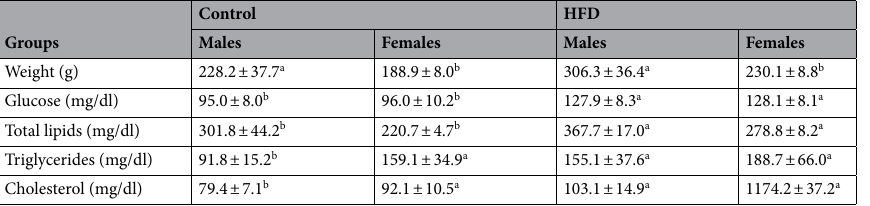
Table 1. Body weight, serum glucose level, and lipid profile in control versus HFD groups after 8 weeks in males and females rats. Data was expressed using mean ± SD. Means in the same raw with small common letters are not significant (i.e. means with different letters are significant). SD standard